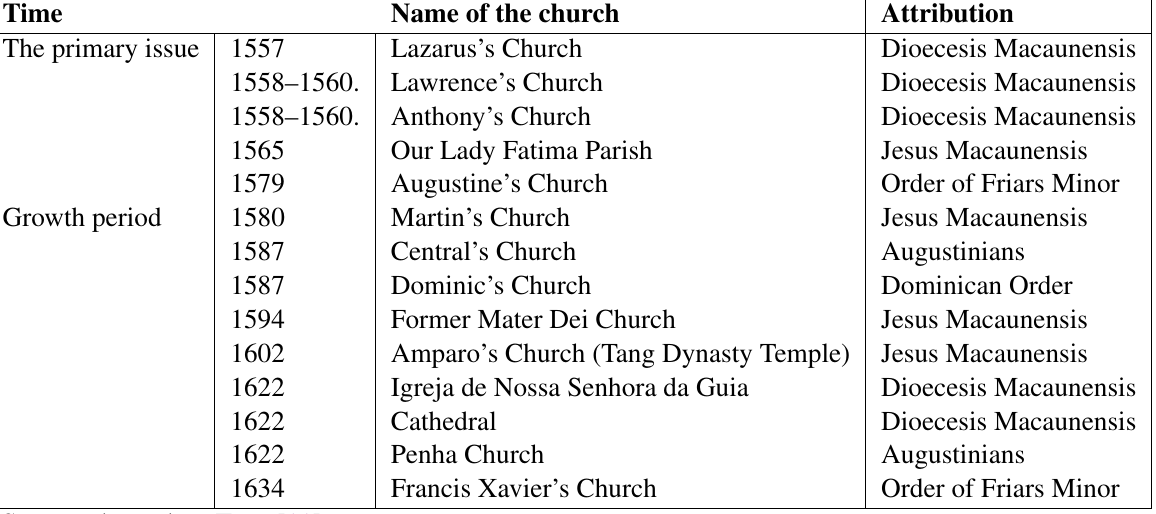
Table 1 Schedule for building churches in